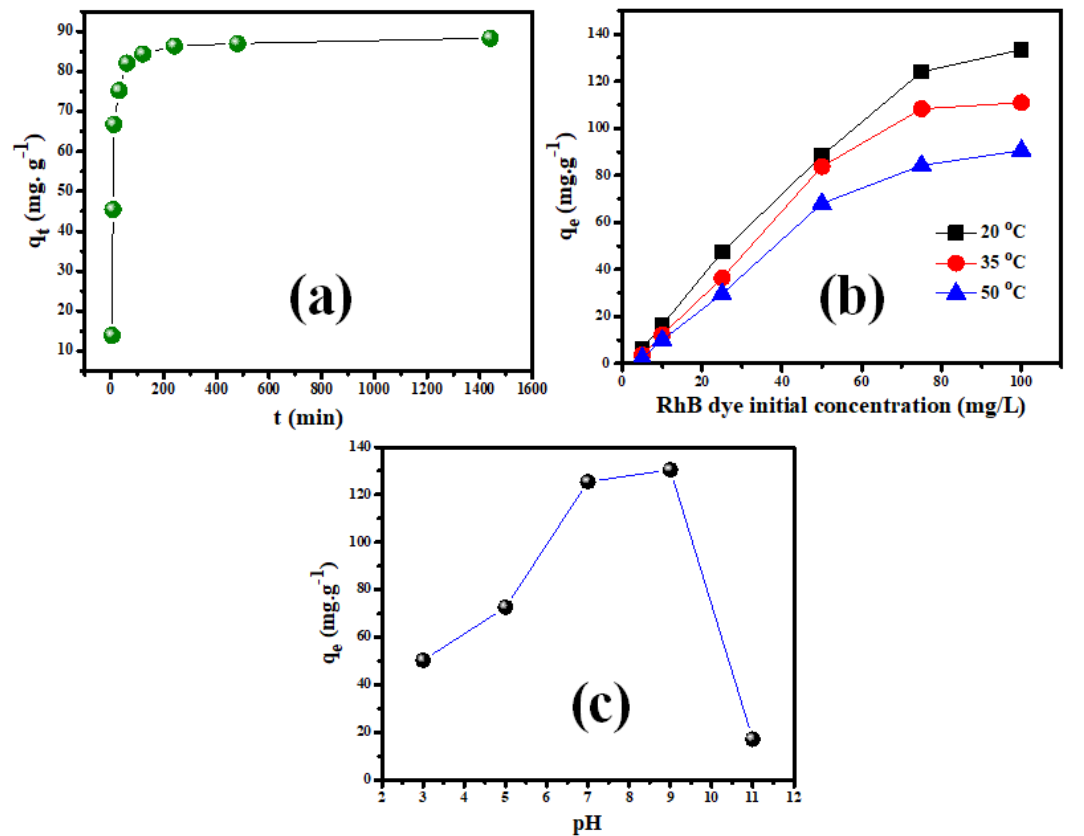
Figure 6. ( a ) The contact time study for the adsorption of Rh-B dye on the synthesized V@TiO 2 , ( b ) the influence of a solution ’ s pH on Rh-B dye sorption, (b) the impact of feeding concentration on the Rh-B sorption on V@TiO 2 at 20 °C, 35 °C, and 50 °C for ( a ) Rh-B dye, and ( c ) The zero-charge investigation of V@TiO 2 .